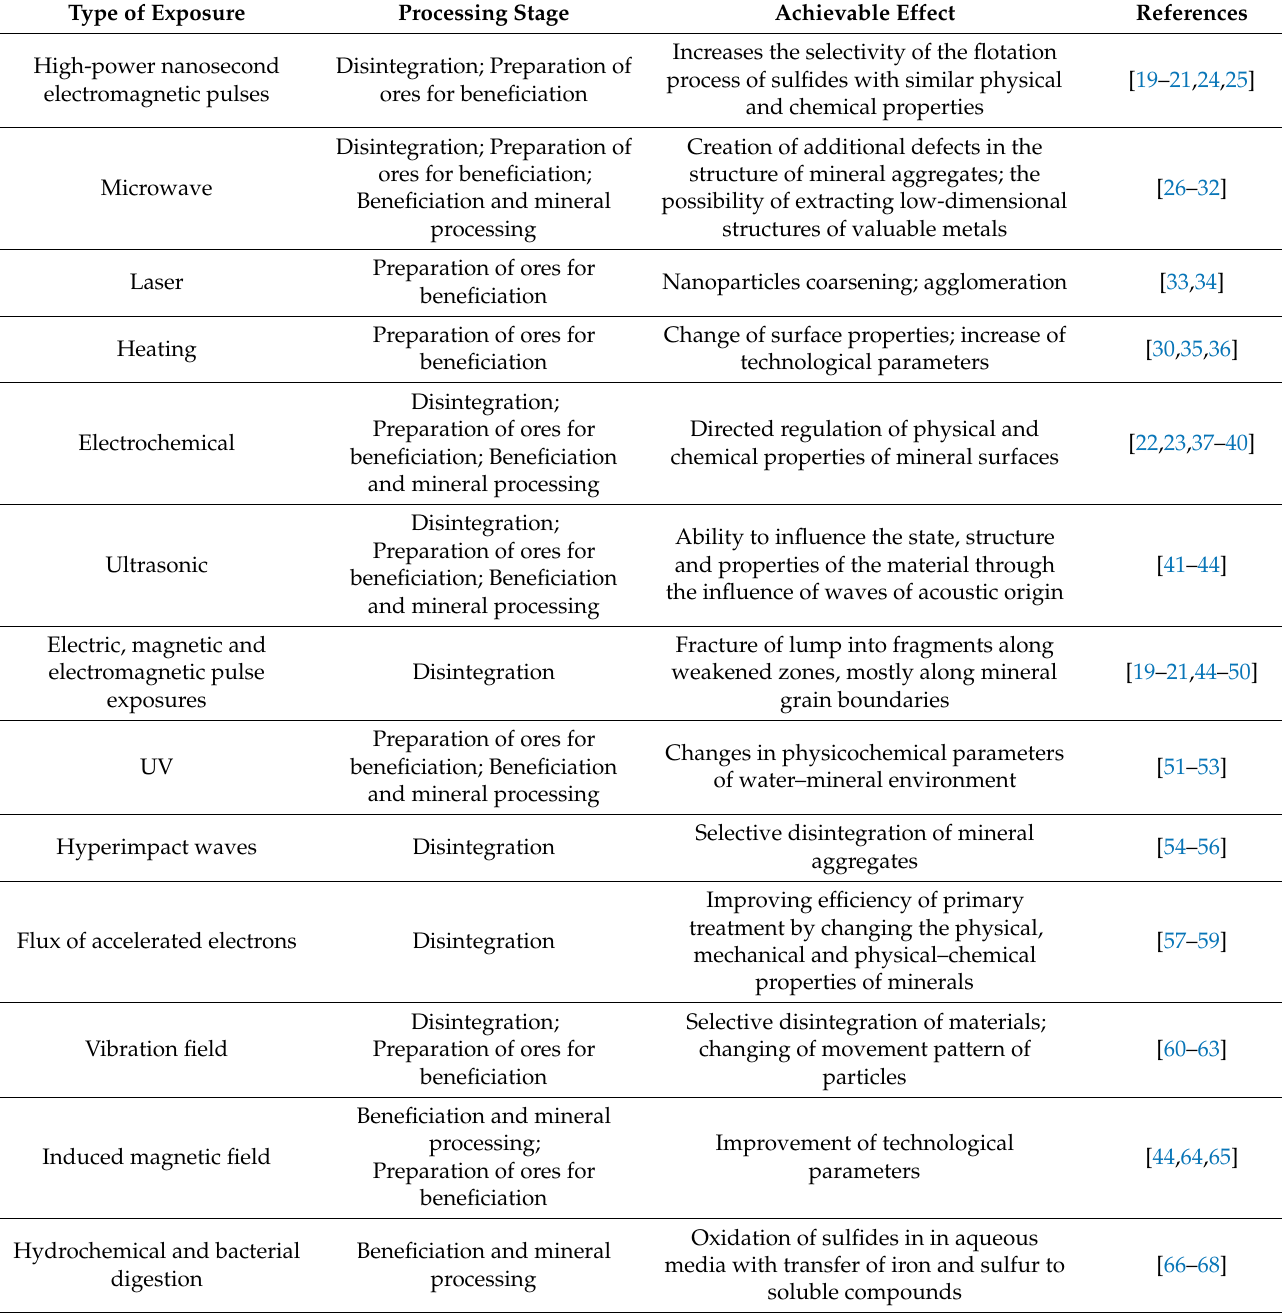
Table 1. Systematization of energy and physical and chemical exposures in preparation, beneficiation and processing of